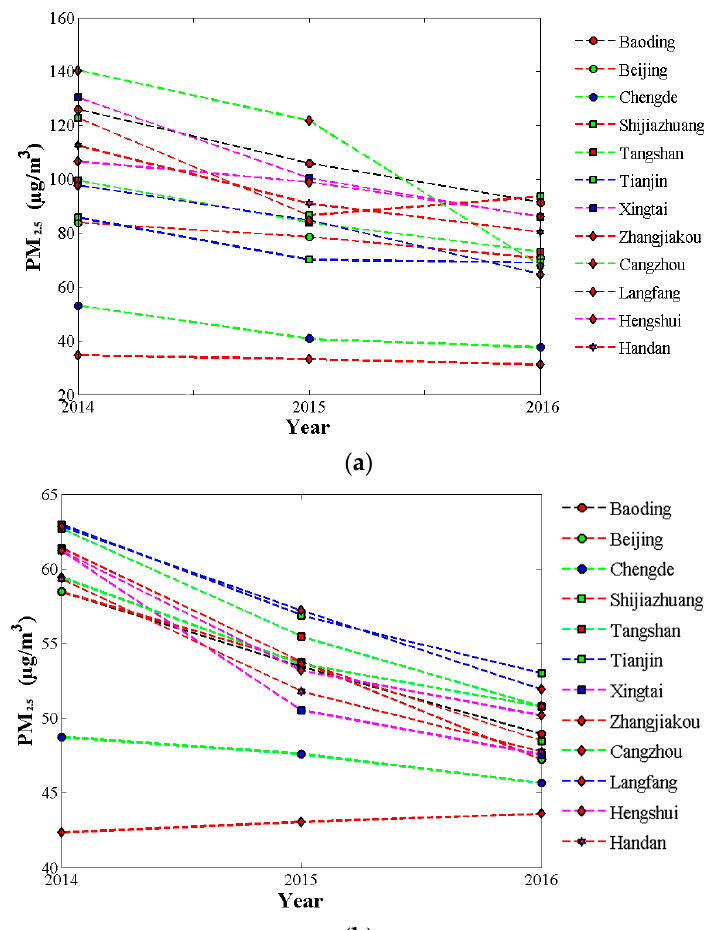
Figure 7. Changes trends in the annual mean PM 2.5 concentration from 2014 to 2016 in the BTH region. ( a ) The change trends of PM 2.5 concentration from the actual ground-measured data; ( b ) The change trends of PM 2.5 concentrations estimation.